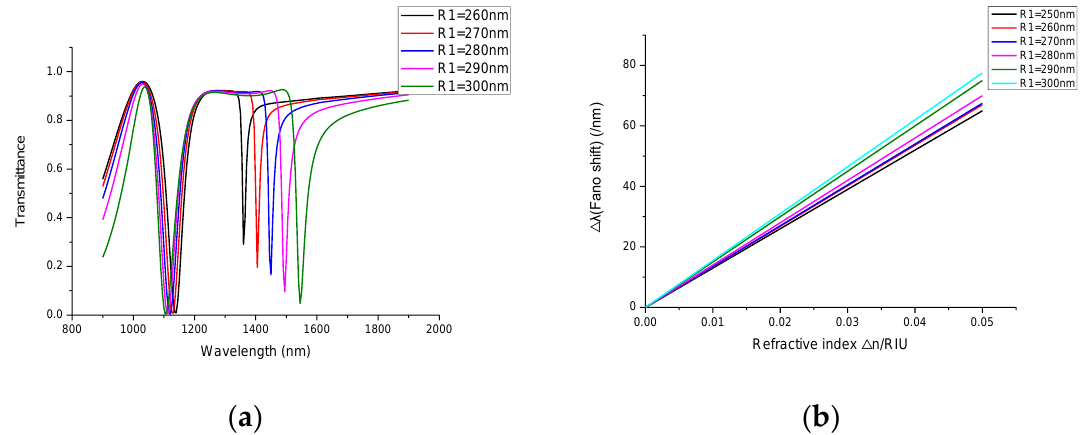
Figure 5. ( a ) Transmission spectrum of di ff erent elliptical long axis R 1 ; ( b ) fitting line of the wavelength of the Fano resonance dip with the changes of elliptical long axis R 1